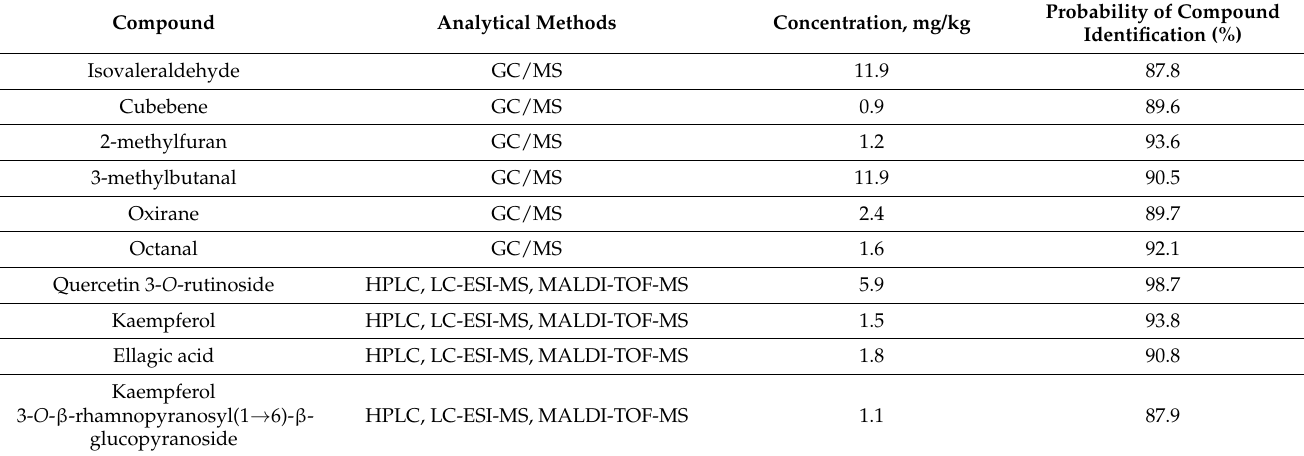
Table 1. Identification of phytochemicals of A. strigosa